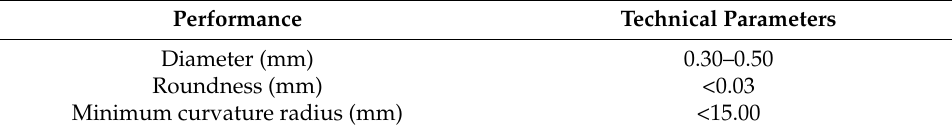
Table 4. Parameter requirements of CFRPF for